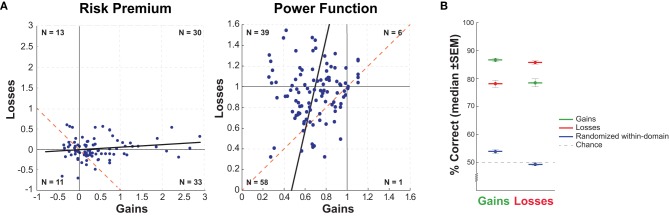
(A) Relationship of within-subject risk premium values across the gains and losses domains. The dashed red line visualizes the correlation predicted by the theoretical reflection effect, with a slope of −1 for the risk premium metric (left) and +1 for the power function metric (right). (B) Cross-domain predictive comparison, percentage of choice behavior correctly predicted by each risk preference, across both domains. Randomized within-domain power function values were obtained through bootstrap analysis, randomly resampling risk preference value and participant's choice sets independently (N = 10,000 iterations, with replacement). The standard error measurement (SEM) value is the median SEM across iterations.